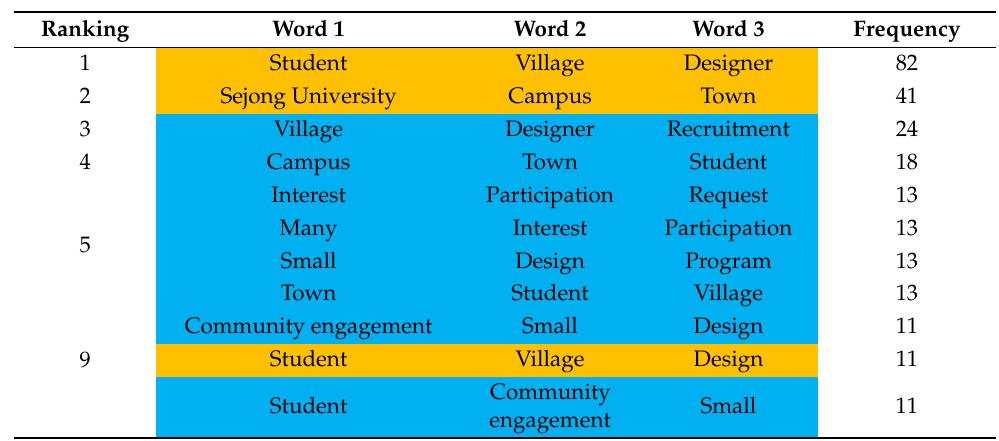
Table 5. Phrases of 3-g frequently used by facilitators.